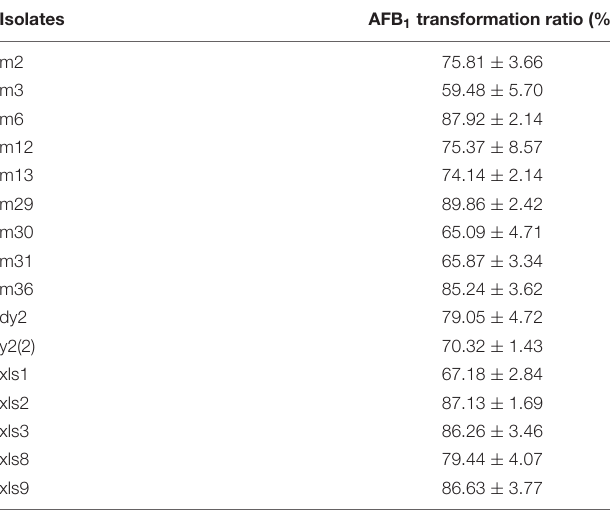
TABLE 1 | Aflatoxin B 1 (AFB 1 ) transformation ability of screened 16 isolates.